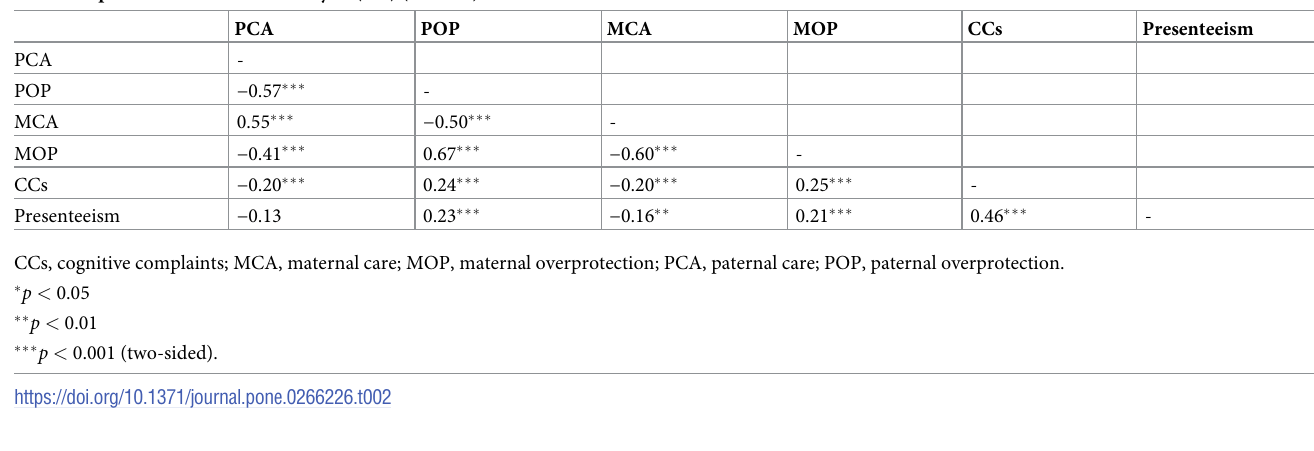
Table 2. Spearman’s correlation analysis ( rho ) (N =